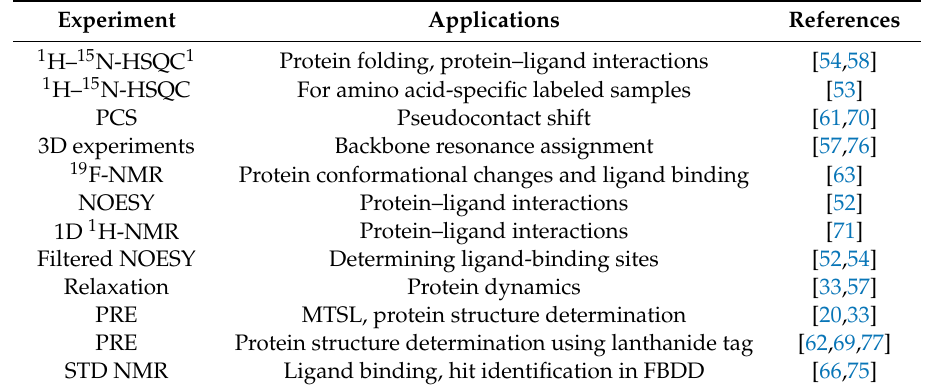
NMR experiments used for flavivirus